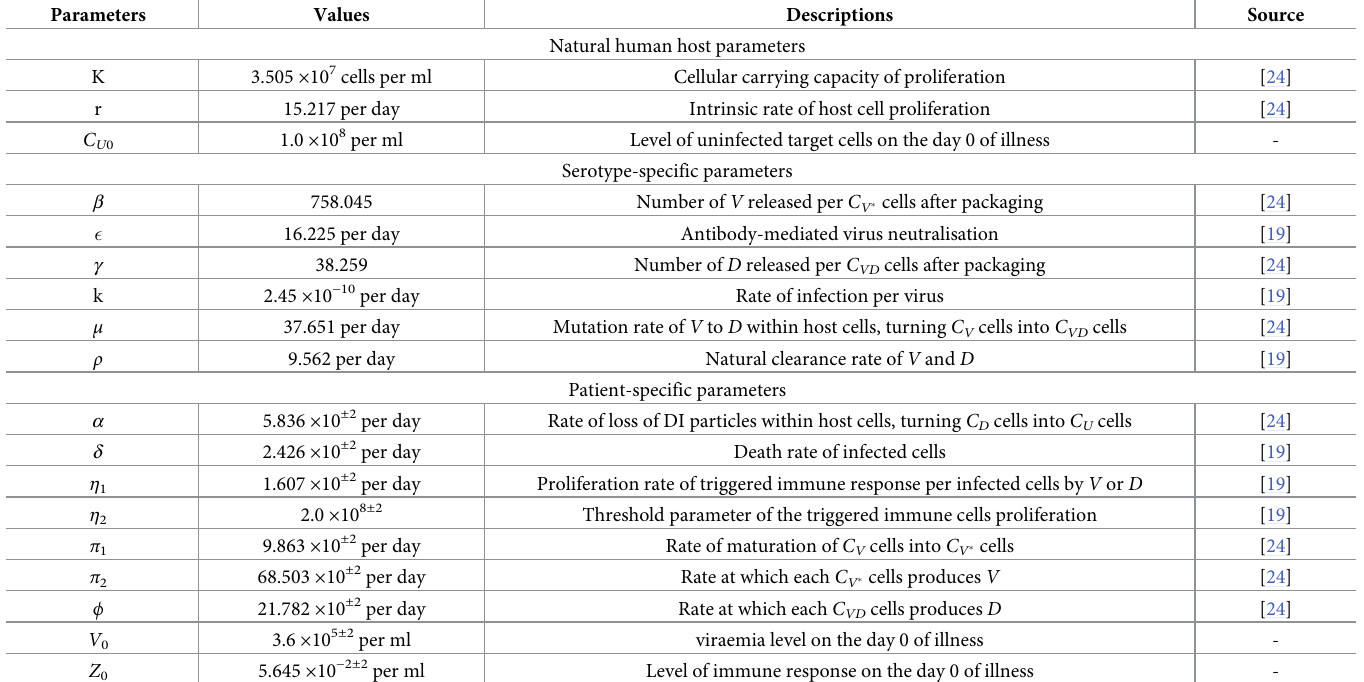
Table 1. Kinetic rate parameters and their sampling ranges used in the